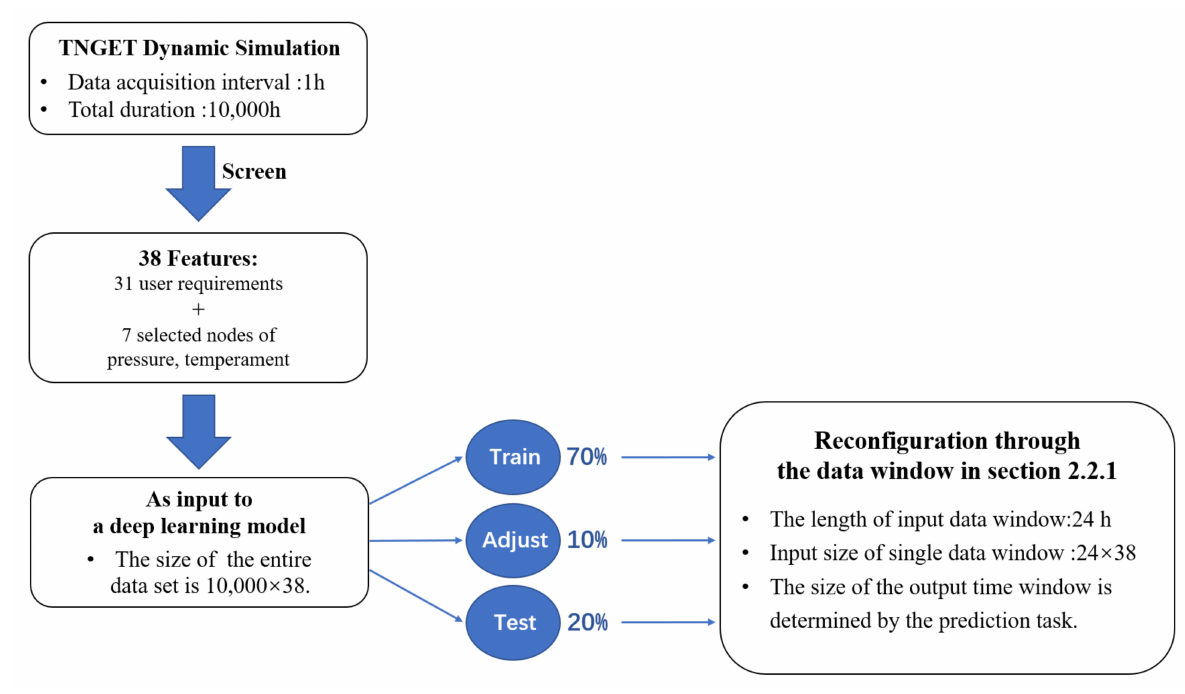
Figure 8. Data sources. Table 2. Comparison of statistical characteristics between original data and generated